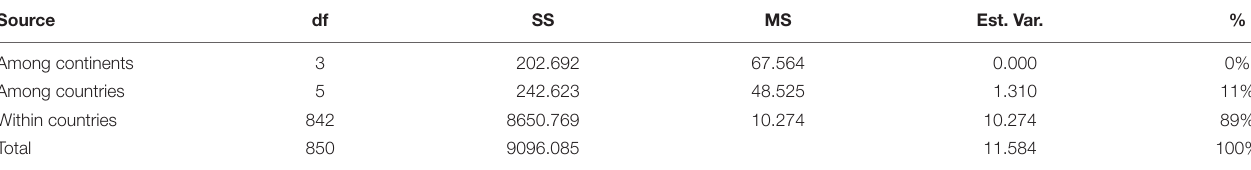
TABLE 4 | Analyses of molecular variance (AMOVA) at different geographic